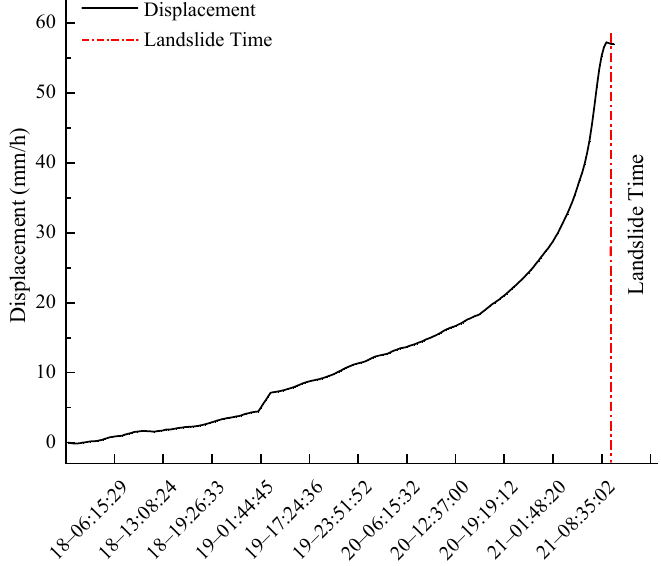
Figure 9. Displacement curve.